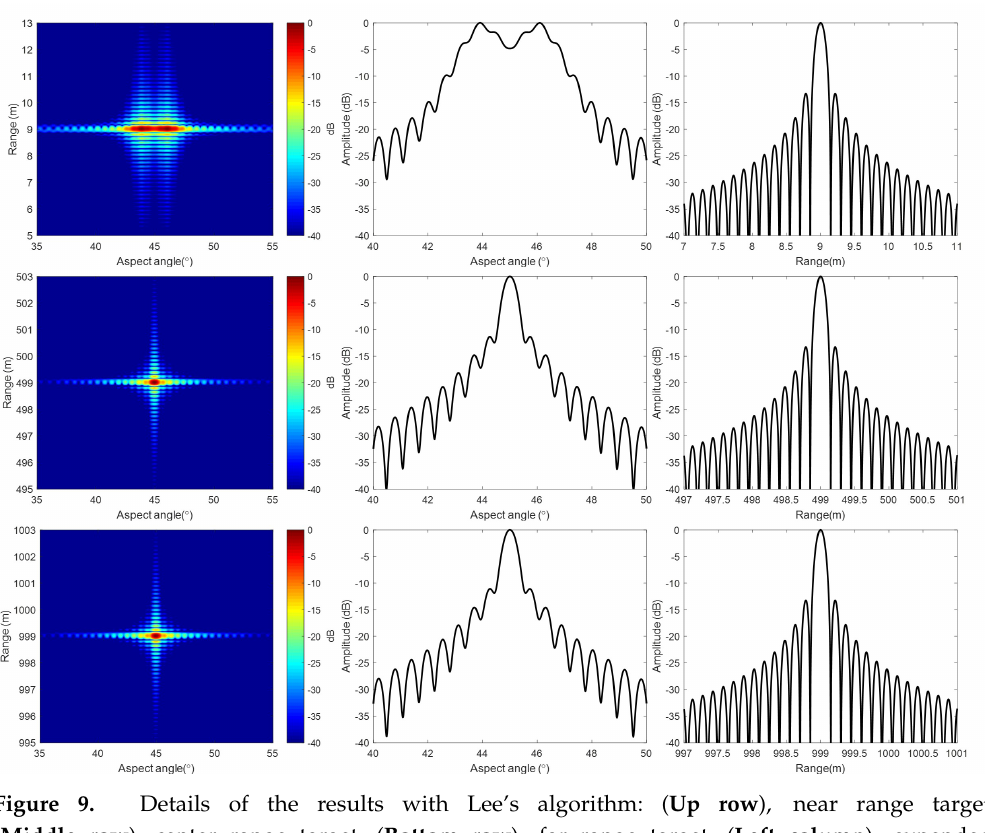
Figure 9. Details of the results with Lee’s algorithm: ( Up row ), near range target. ( Middle row ), center range target. ( Bottom row ), far range target. ( Left column ), expended two-dimensional (2-D) image. ( Middle column ), azimuth profile through the pulse peak. ( Right column ), range profile through the pulse peak.